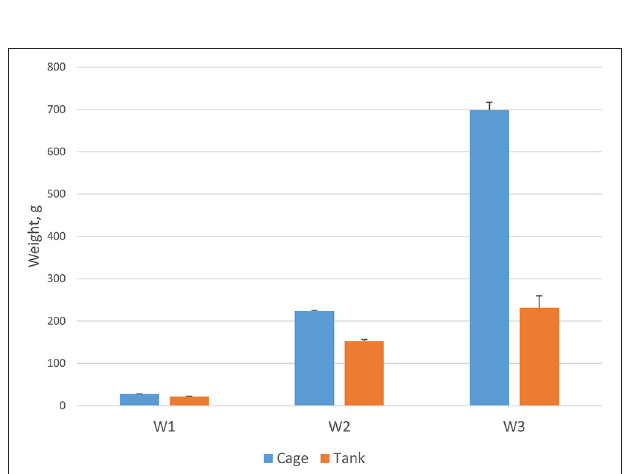
FIGURE 3 | Body weight (g) and length (cm barramundi ( P <